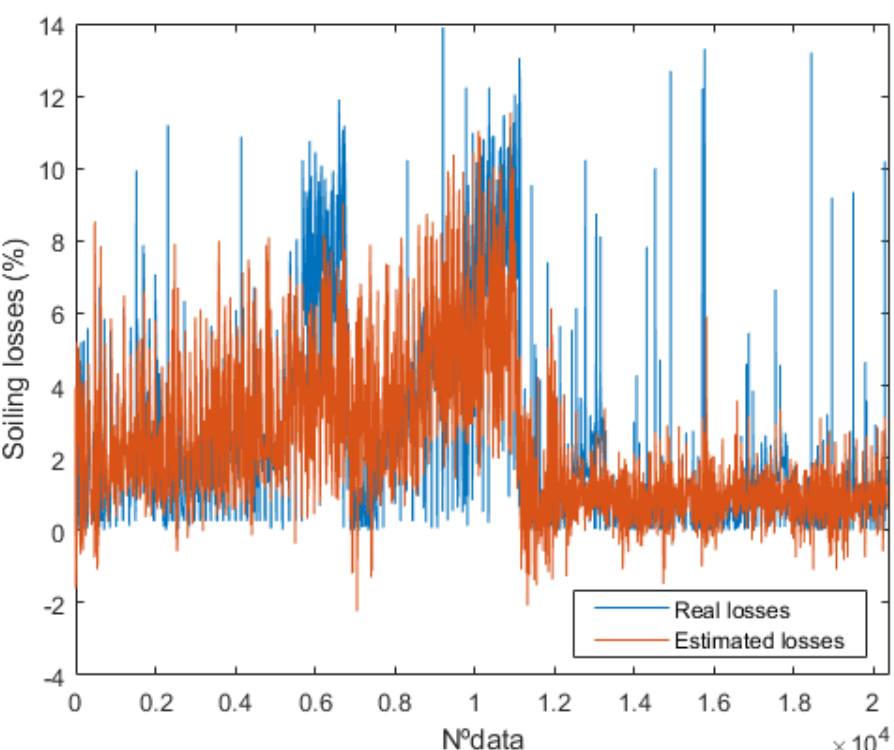
Figure 8. Comparison of real versus estimated losses without Isc.